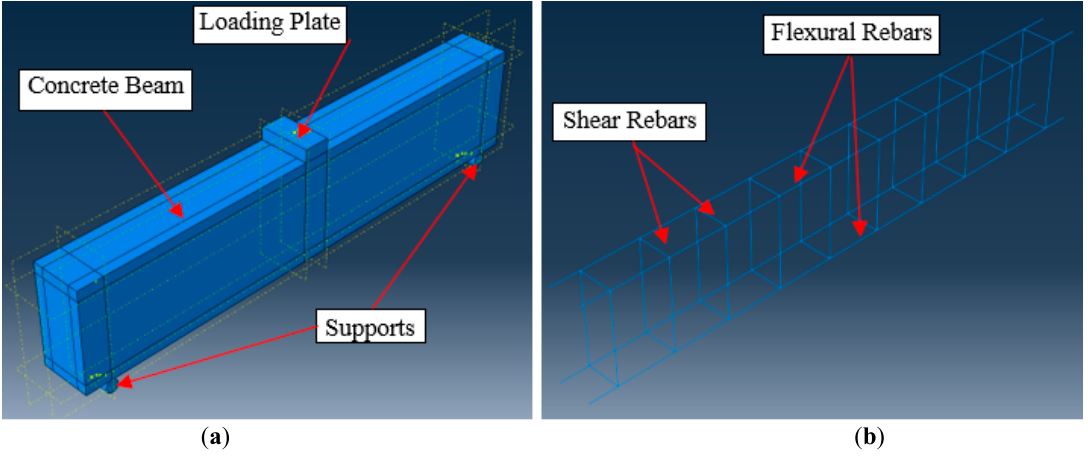
Figure 5. Numerical model details: ( a ) Concrete beam details, ( b ) Steel reinforcement details.